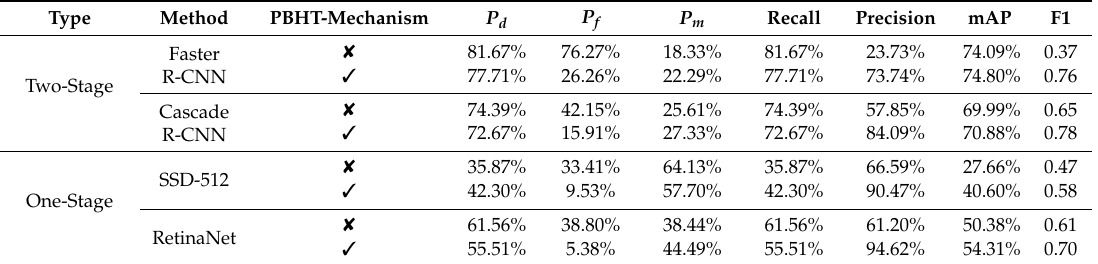
Table 13. Detection performance with and without PBHT-mechanism on the entire scenes.